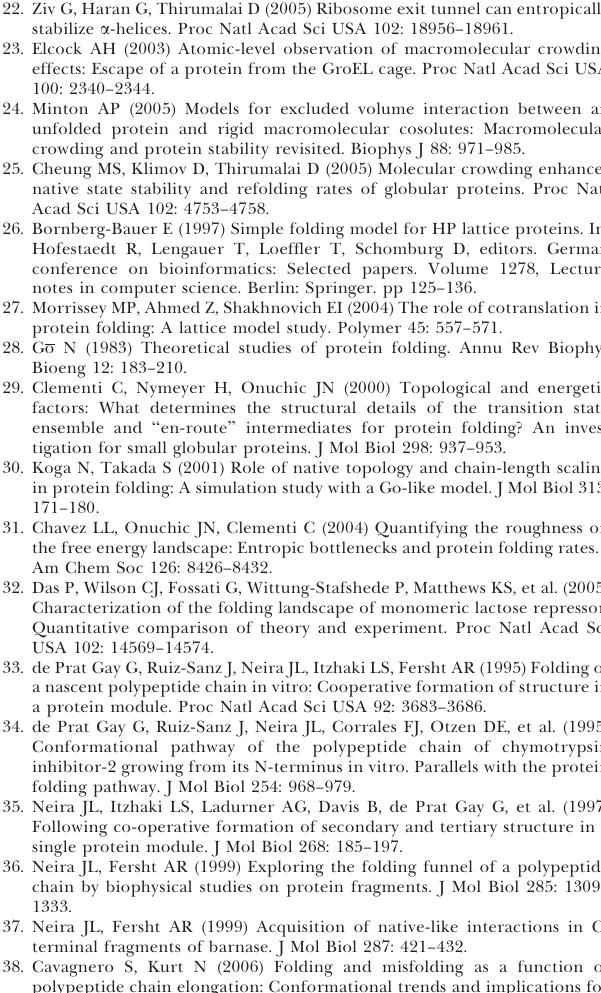
Figure S13. Effect of Altering the Balance between Local and Non- local Interactions on Q in Coupled Synthesis–Folding Simulations of CI2 (A) Plot of free energy, G, versus Q at 300 K full-length CI2 computed with the four parameter sets investigated (see text). (B) Plot of heat capacity versus temperature for full-length CI2 computed with each parameter set. (C) Mean values of Q during coupled synthesis–folding